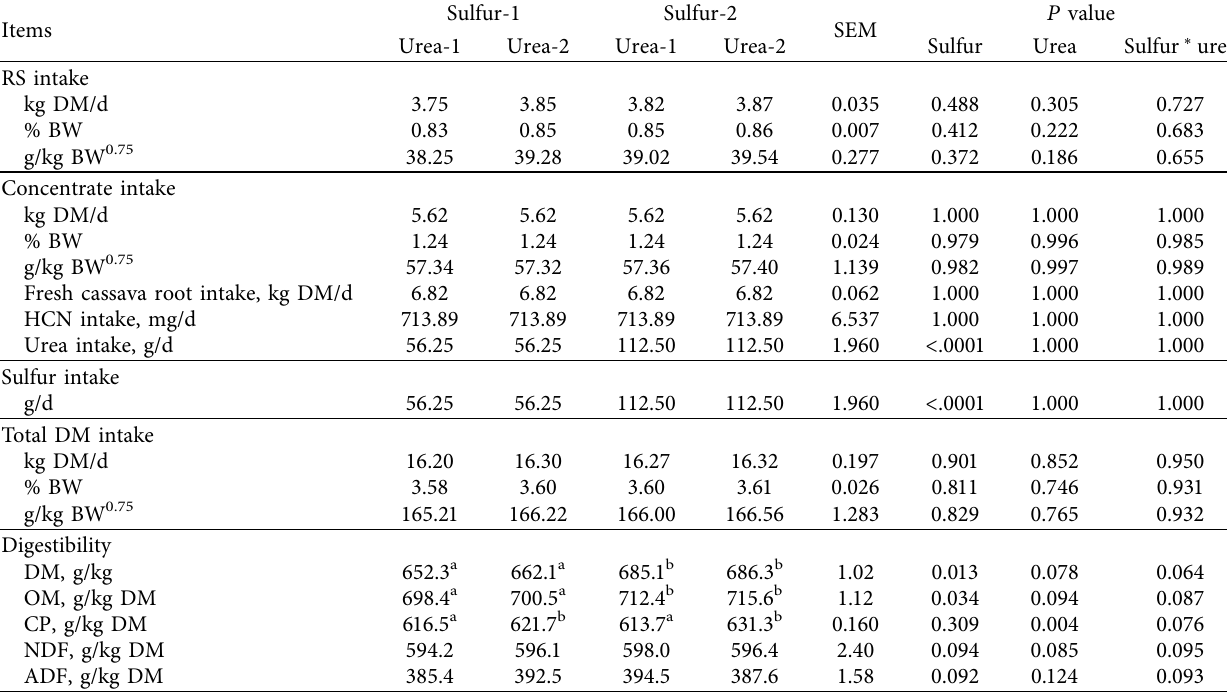
Table 2: Effect of sulfur and urea levels on feed intake and nutrient digestibility in dairy cows.